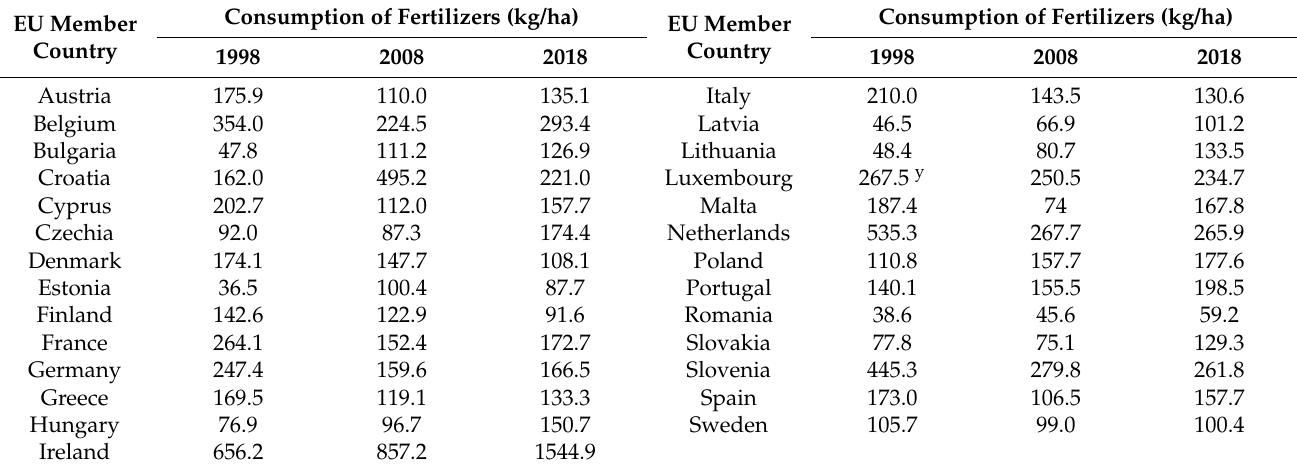
Table 2. Annual consumption of fertilizers z in kilogram per hectare (kg/ha) of agricultural land in the 27 member states of the European Union in 1998, 2008, and 2018.